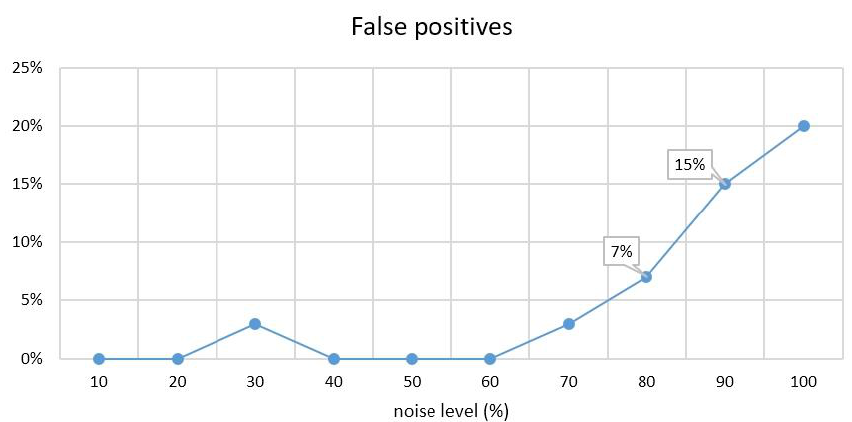
Figure 7. The false positives of the framework.